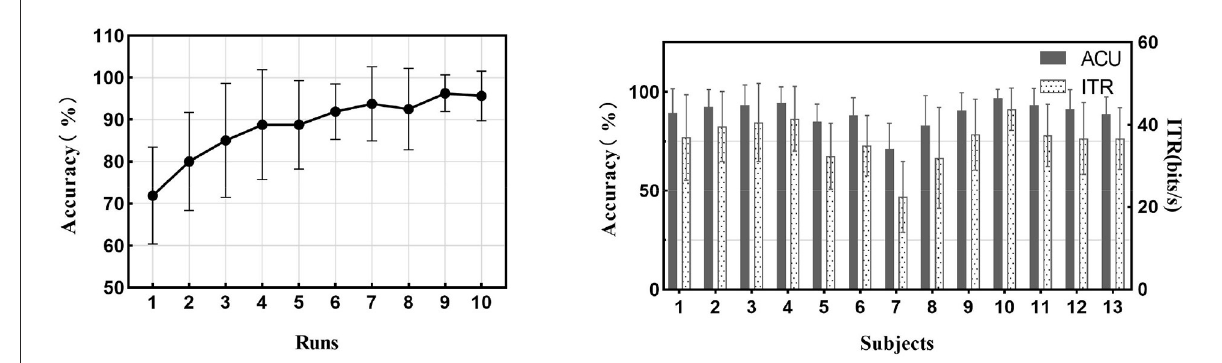
FIGURE12 The BCI performance of 13 subjects on the nine-target online experiment. The left figure shows the increasing trend of average accuracies against the number of runs. The figure on the right shows the average performance of trials of each of the 13